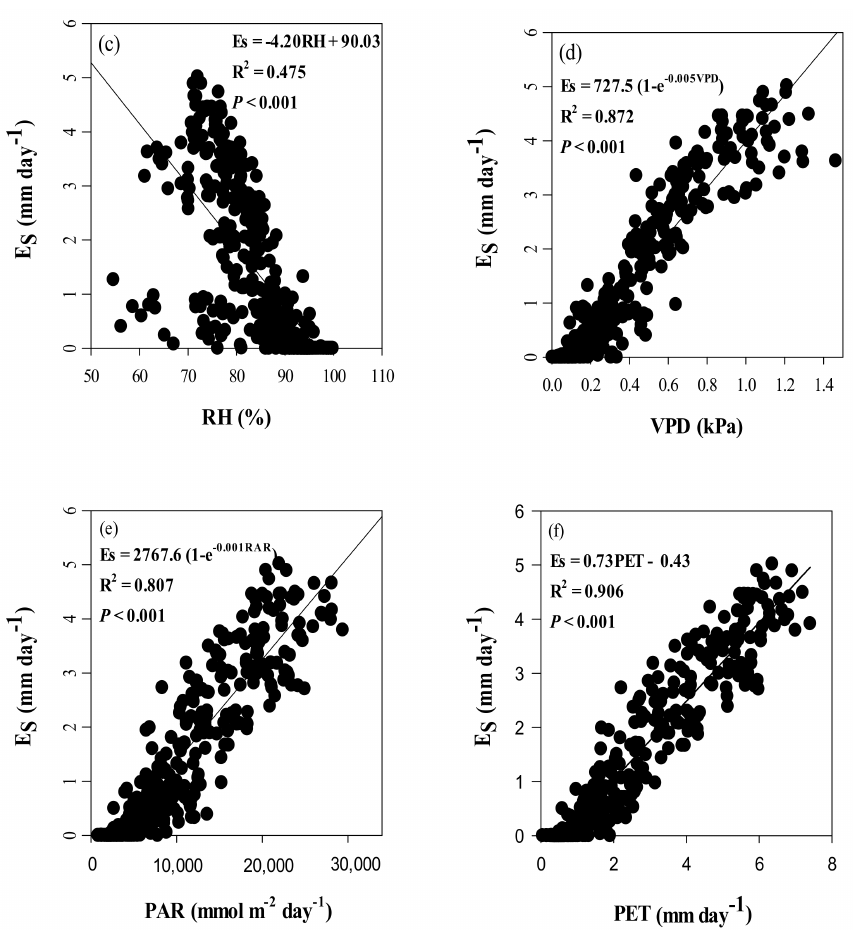
Figure 8. The relationships between the daily stand transpiration ( E s ) (mm) and ( a ) rainfall (mm); ( b ) air temperature (Ta) ( ◦ C); ( c ) photosynthetically-active radiation (PAR) (mmol m − 2 day − 1 ); ( d ) air relative humidity (RH) (%); ( e ) vapor pressure deficit (VPD) (Kpa); and ( f ) potential evapotranspiration (PET) (mm) during the study period.